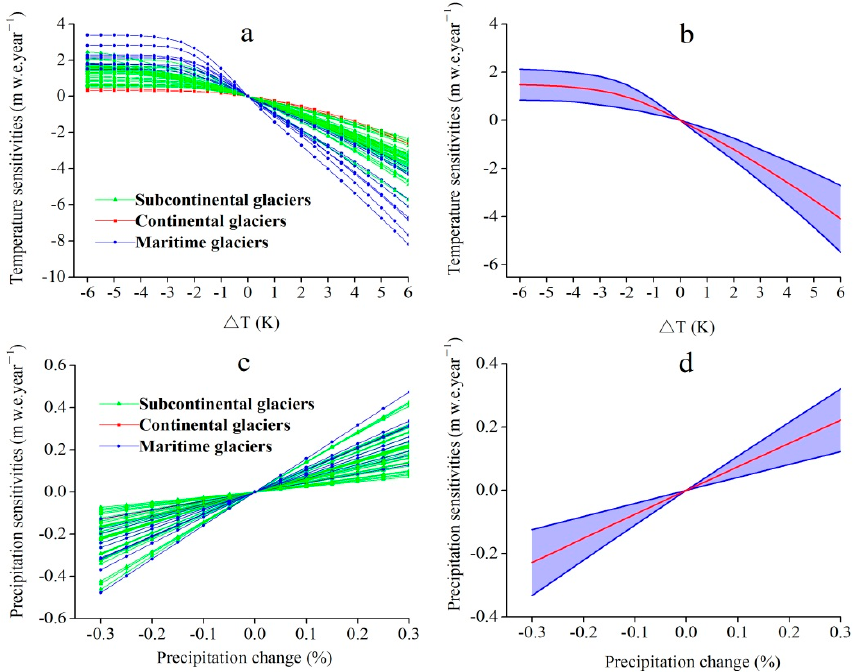
Figure 3. Mass balance sensitivities (m w.e. year − 1 ) to ( a , b ) temperature and ( c , d ) precipitation change for the 45 glaciers. In ( b ) and ( d ), the red line shows the mean sensitivity across the 45 glaciers, and the blue shading shows the standard deviation.